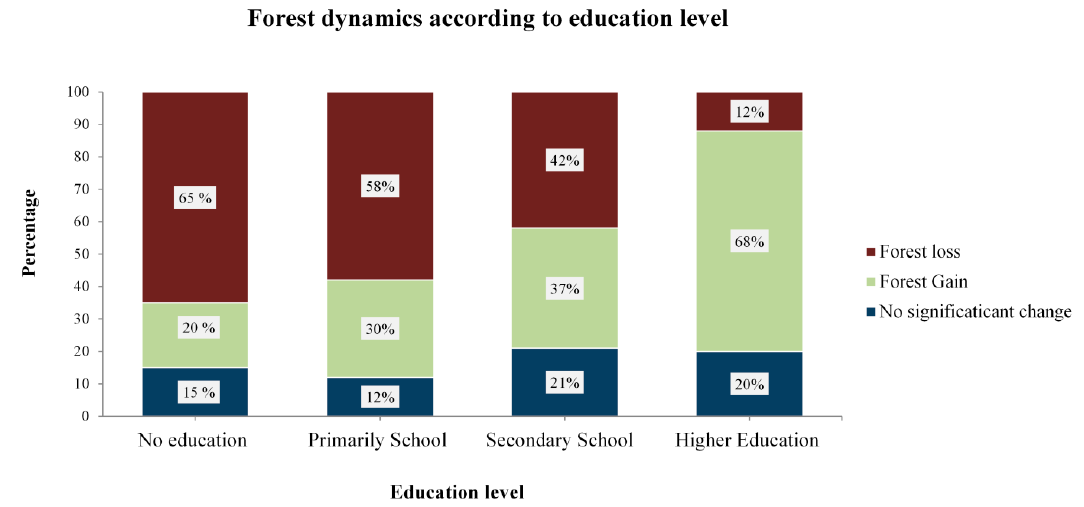
Figure 7. Dynamics of the forest based on the education level of the respondents.